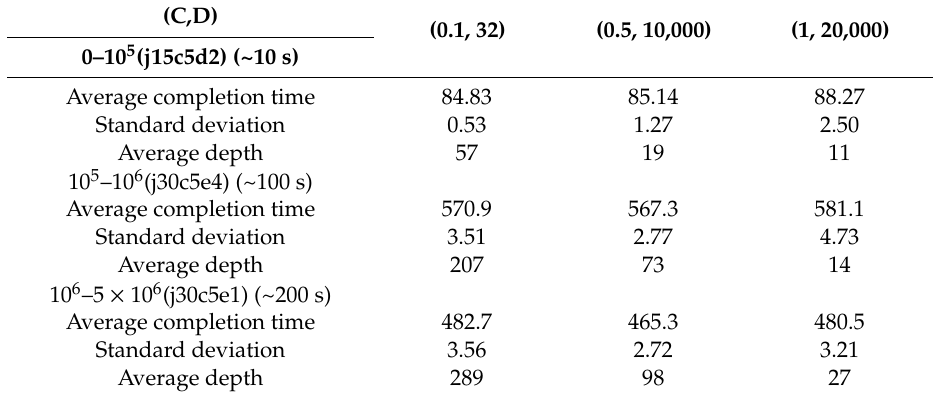
Table 3. Results of improved single-player Monte-Carlo tree search (ISP-MCTS) for the di ff erent settings.